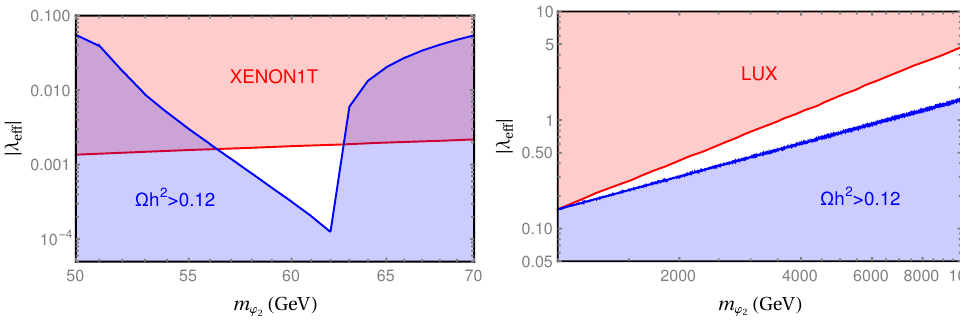
Figure 2 . Viable mass regions where the field ϕ 2 of the simplified model described in the text behaves as a dark matter candidate. The red regions correspond to the current direct detection lim- its [12, 13]. The blue regions represent values of the effective coupling λ relic density is incompatible with the Planck measurement